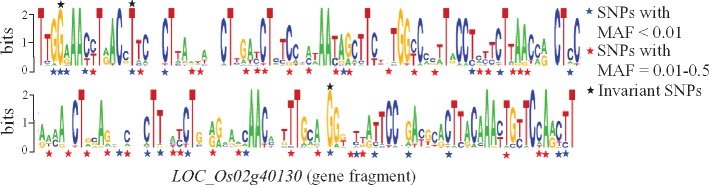
—Sequence logo of one fragment of an exemplar gene harboring SNPs positions that illustrate sites with high intraspecific variation yet low interspecific variation. Blue stars represent the rare SNPs of MAF <0.01. Red stars represent SNPs of MAF >0.01 but <0.5. Black stars represent cross-species “invariant” SNPs that are consistent throughout the multiple sequence alignment blocks across species. This fragment is located in Chr2: 24,293,421–24,293,580 of the rice genome.